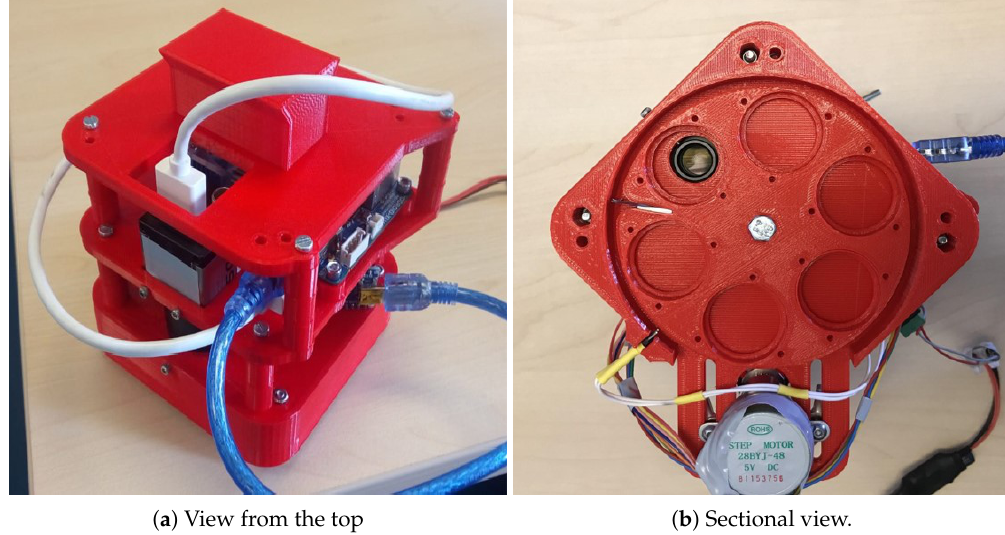
Figure 5. Views of the final camera